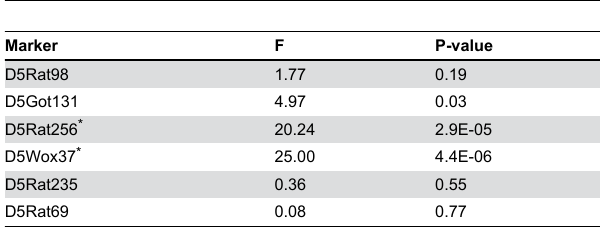
Table 2. Association test between marker and body weight.